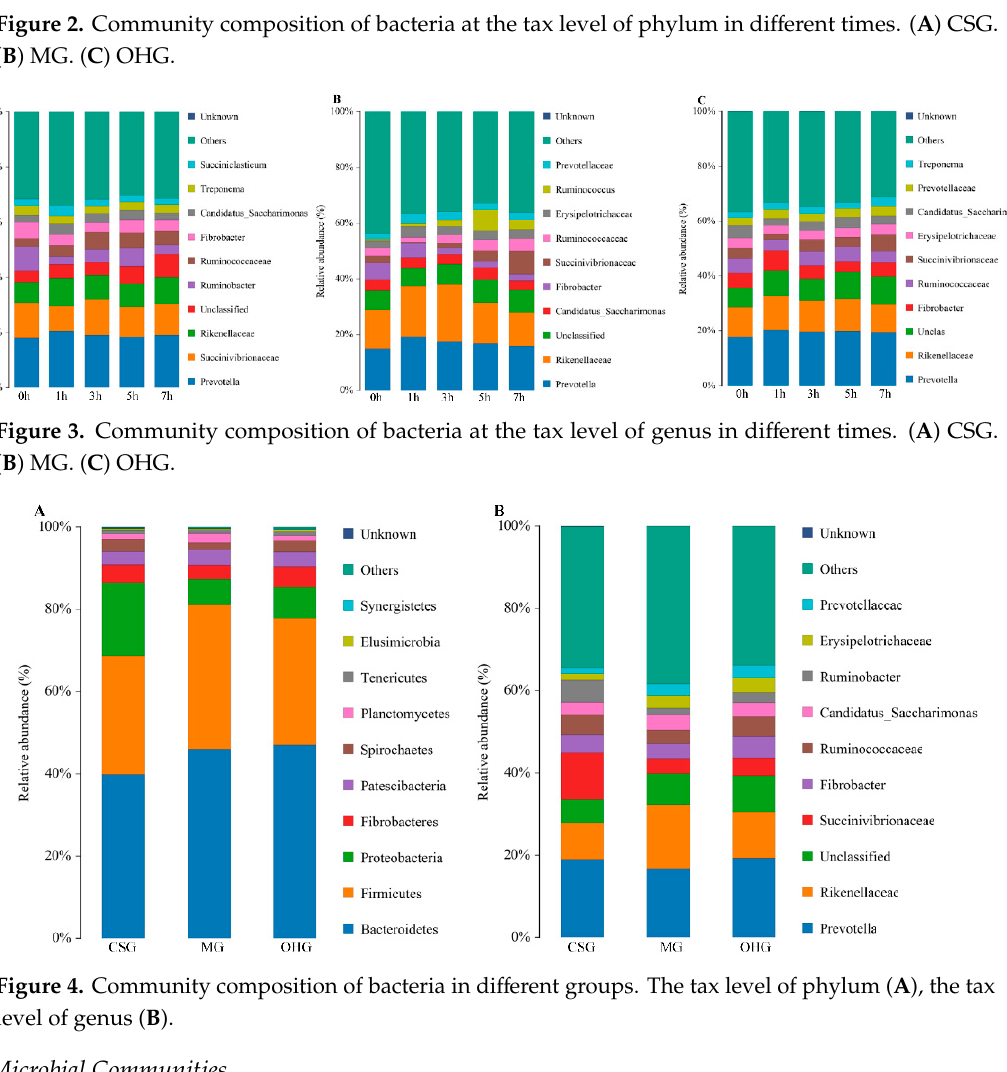
Figure 2. Community composition of bacteria at the tax level of phylum in different times. ( A ) CSG. ( B ) MG. ( C ) OHG.